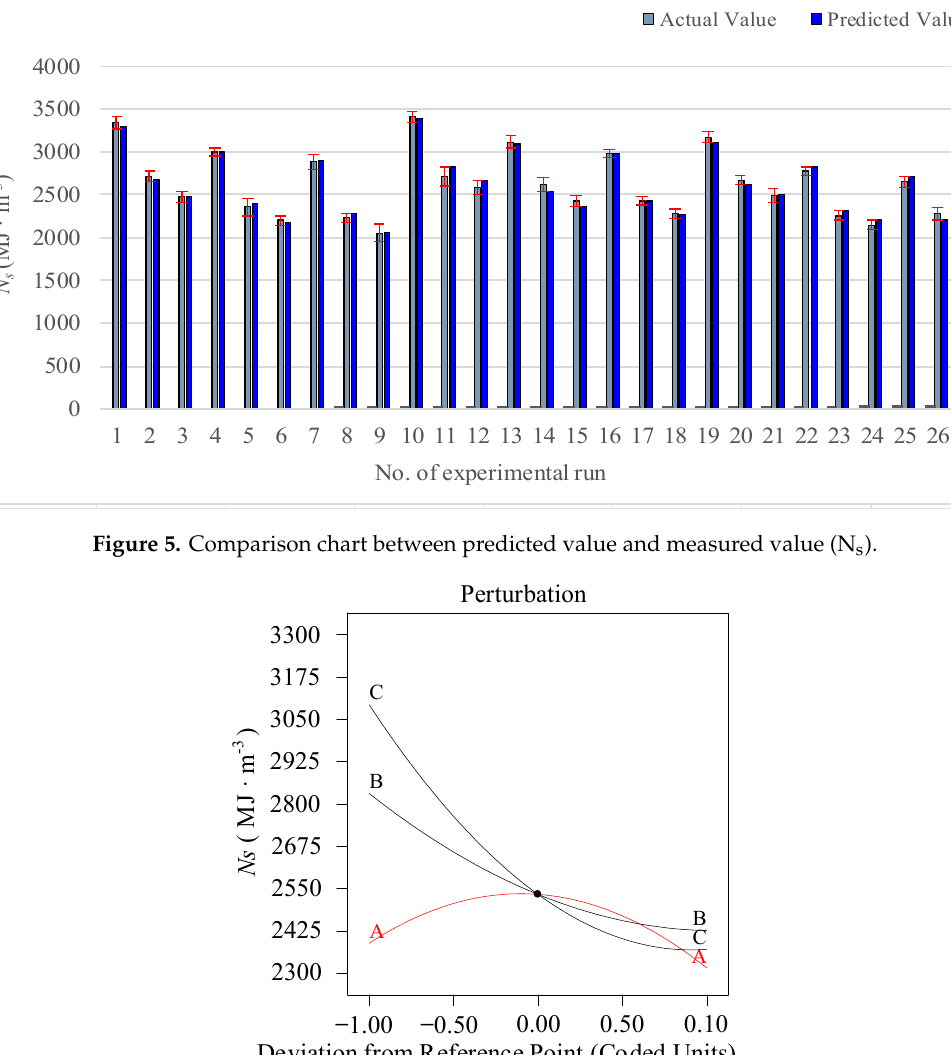
Figure 6. Perturbation diagram ( N s ).